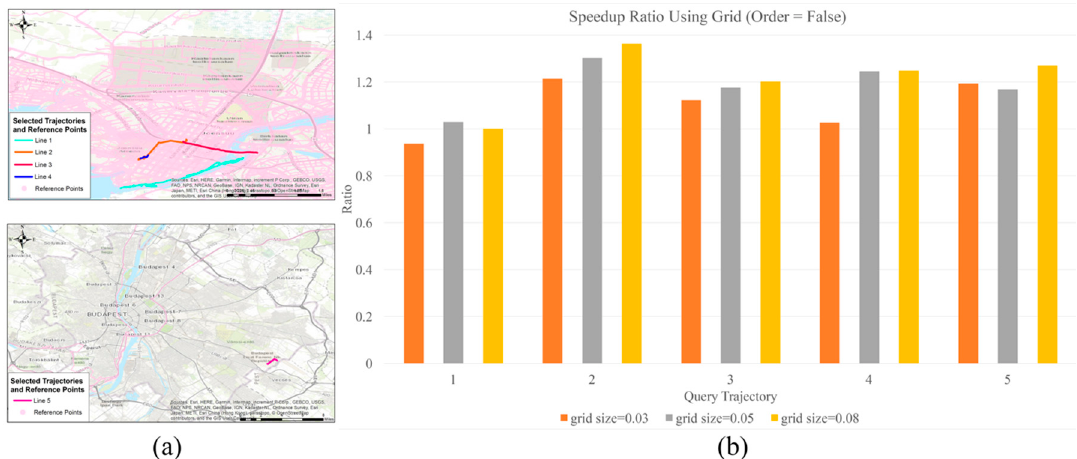
Figure 11. Comparing speedup ratio of Mopsi data (Group 3.b) using girds and without using grids: ( a ) The distribution of selected trajectories; ( b ) the comparison result.